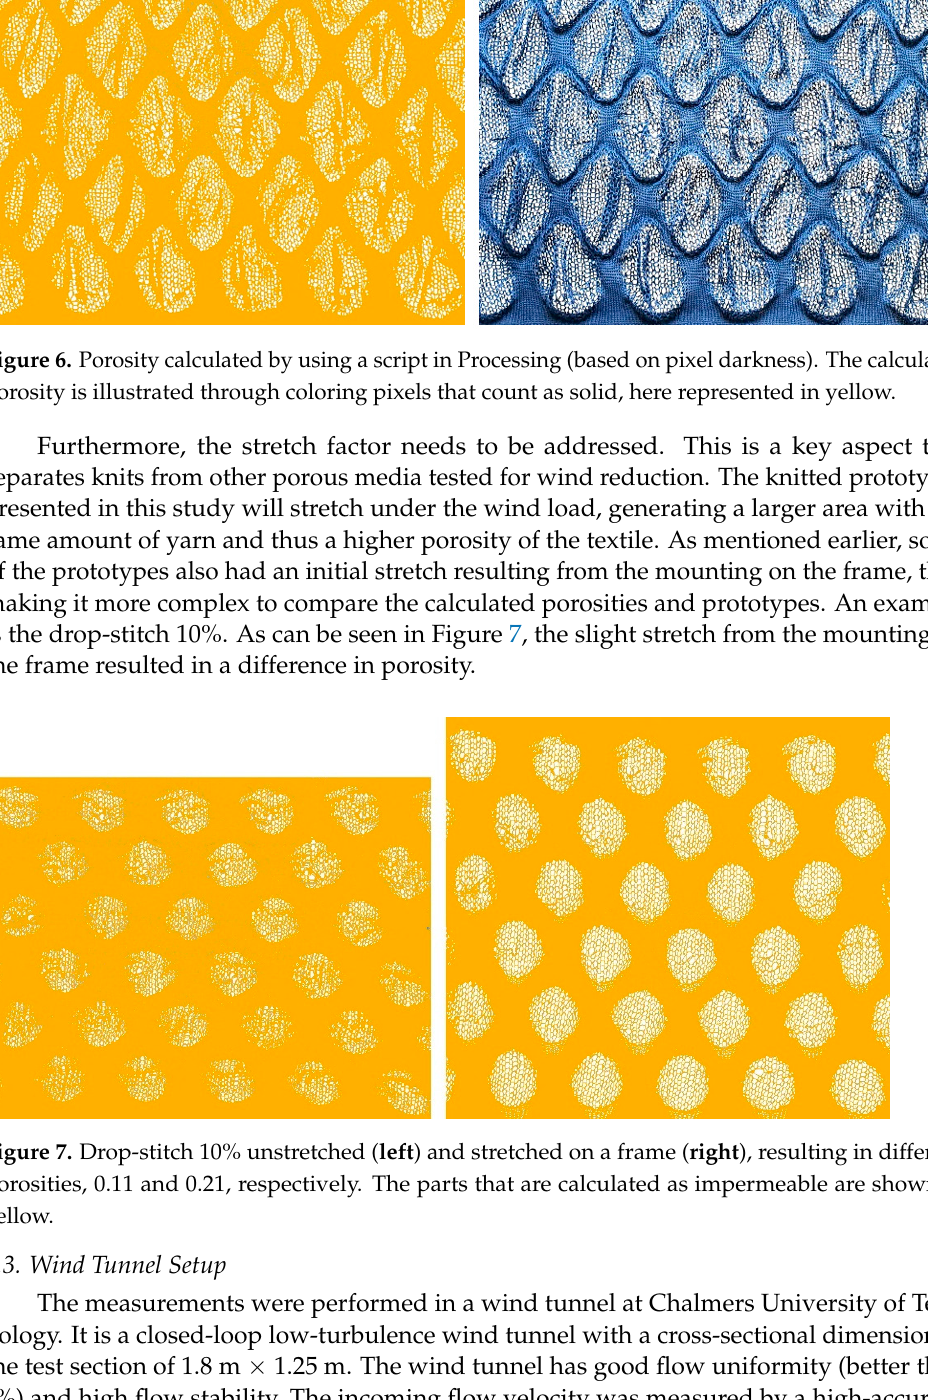
Figure 6. Porosity calculated by using a script in Processing (based on pixel darkness). The calcu- lated porosity is illustrated through coloring pixels that count as solid, here represented in yellow.